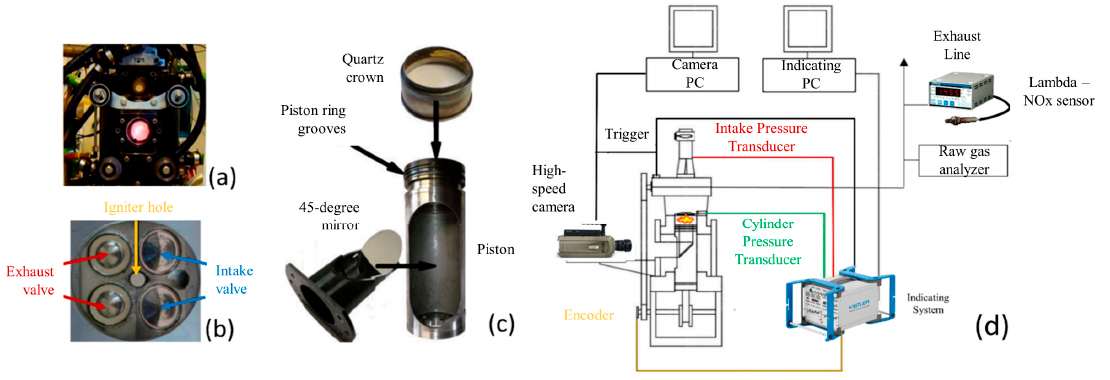
Figure 2. Details of the ( a ) optical access engine, ( b ) engine head, ( c ) optical apparatus and ( d ) schematization of the measurement apparatus.